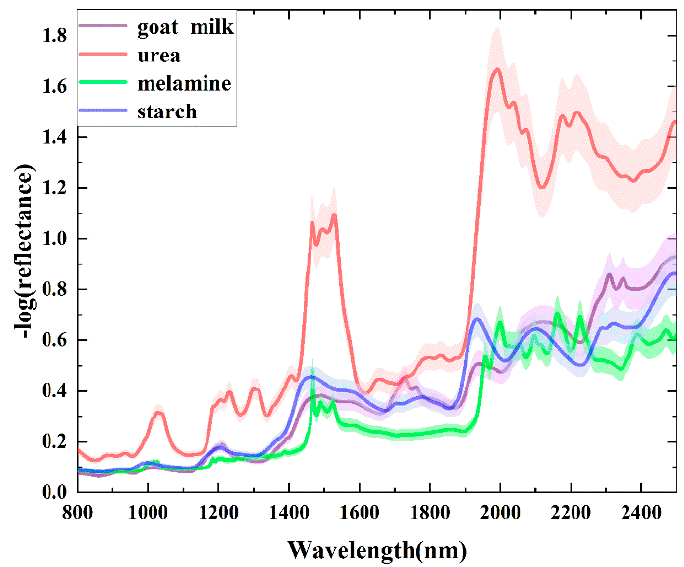
Figure 2. Average spectra of pure urea, melamine, starch, and goat milk powder with shaded error bands.